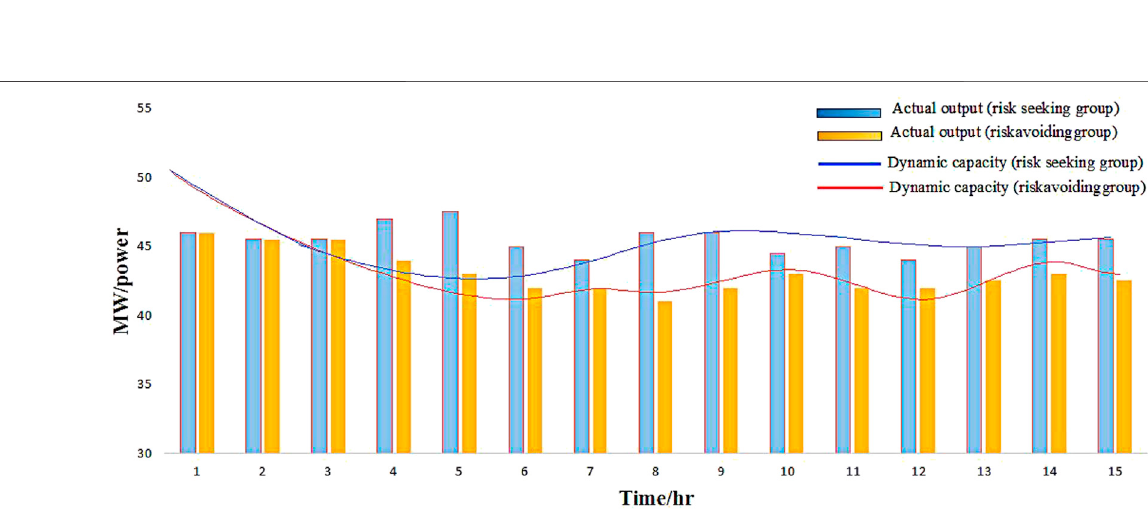
FIGURE 9 | Dynamic capacity of